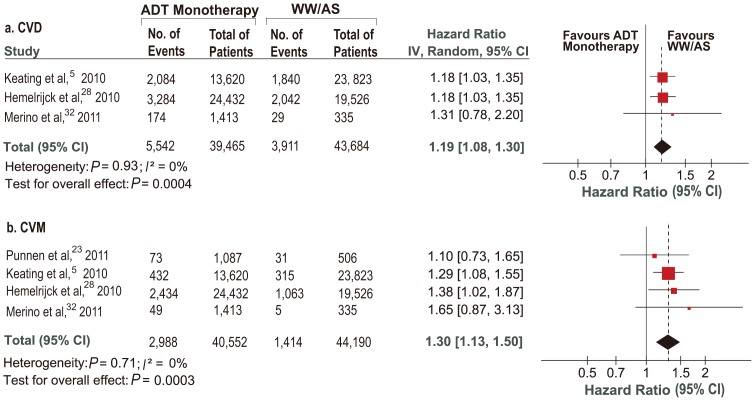
HRs of Cardiovascular Events Related to ADT Monotherapy vs WW/AS.